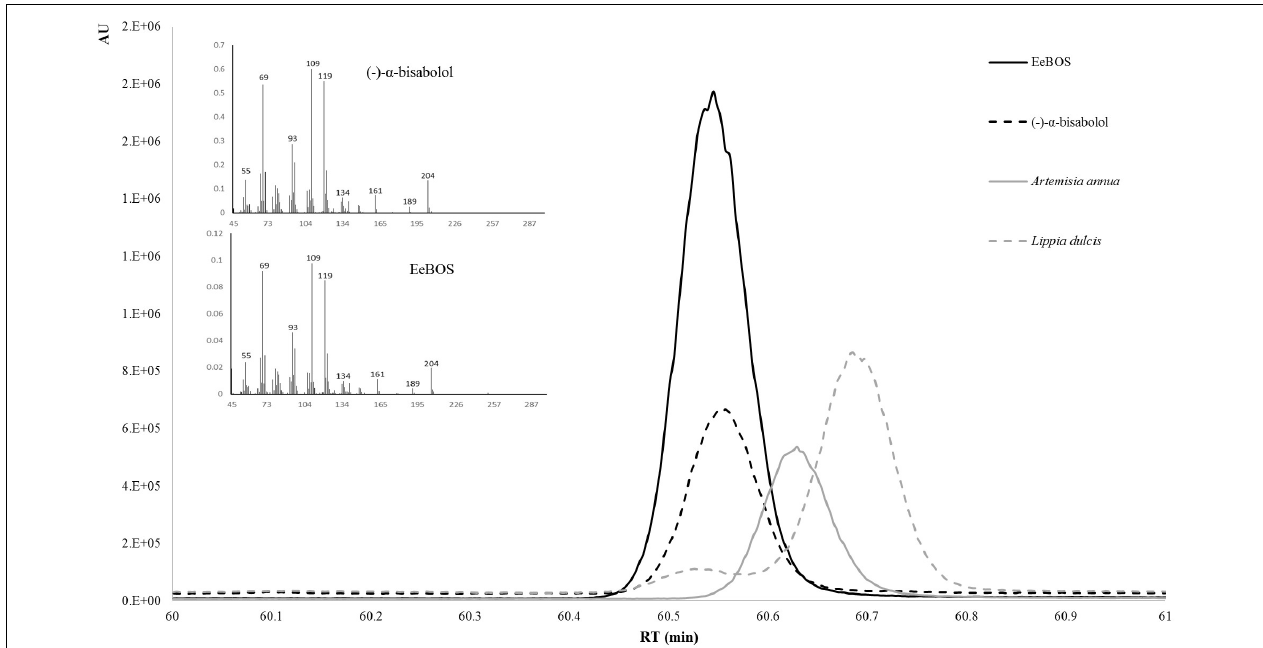
FIGURE 4 | Enantioselective identification of the product of EeBOS. The product of the in vitro enzymatic assay with FPP were analyzed by GC-MS with a cyclodextrin column (solid black line). To confirm the enantiomer the EeBOS sample was compared with pure standards of [(–)- α -bisabolol; dotted black line], a known (+)-epi-bisabolol ( L. dulcis extracts; dotted gray line), a known (+)- α -bisabolol (extract of N. benthamiana expressing A. annua bisabolol synthase; solid gray line). On the left side of both panels are the MS spectra for the (–)- α -bisabolol standard and EeBOS the in vitro enzymatic assay with FPP.